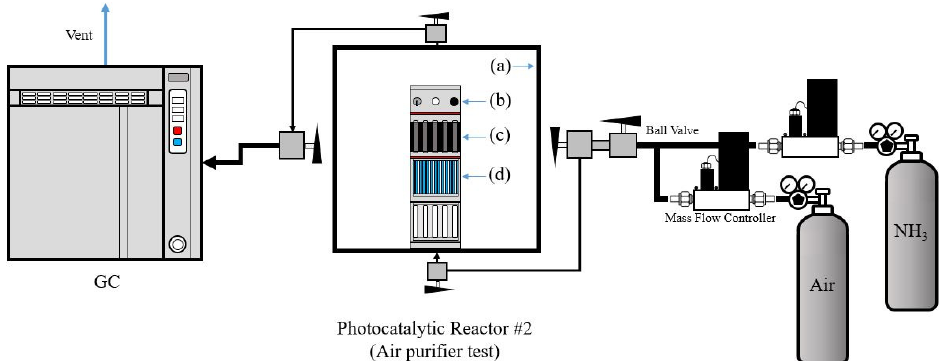
Figure 3. Schematic image of reactor #2 for the evaluation of photocatalytic air purifier performance in a simulated indoor environment without air circulation: ( a ) (acrylic) square-type dark-box chamber, ( b ) central control system for the DC fan and blue LED light source, ( c ) DC fan and DC power supply, and ( d ) photocatalytic air purifier.